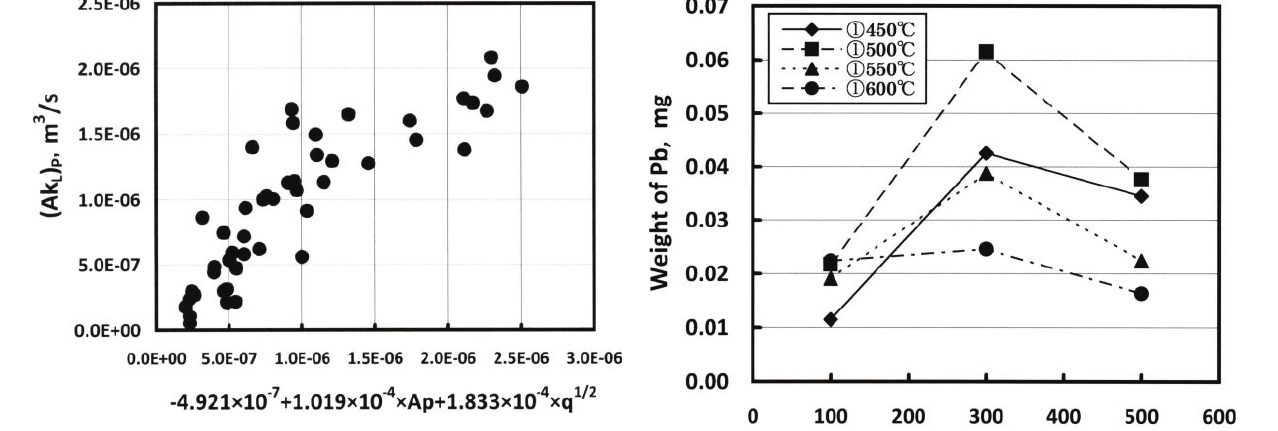
Figure 11. Influence of the plume eye area and gas flow rate on surface reaction rate.